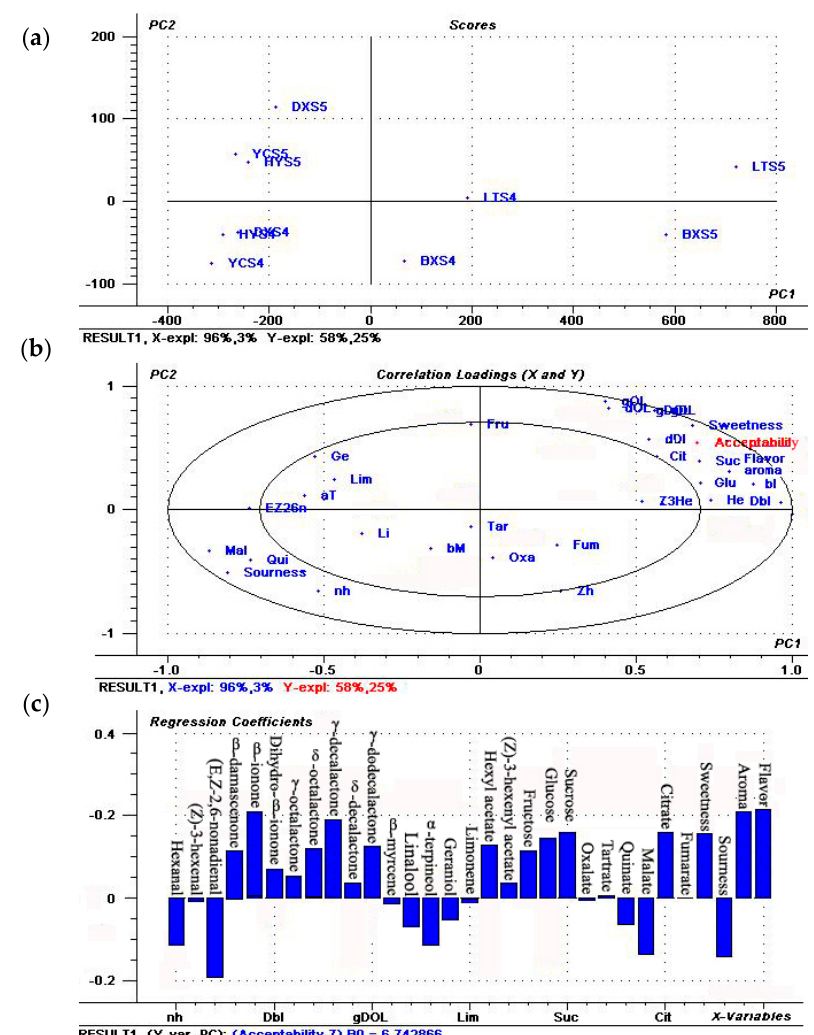
Figure 6. The PLSR model of flavor compounds and sensory attributes of apricot fruit. ( a ) Scores plot, the first two capital letters represent the genotypes described in Table 1 and Tables S4 and S5 represent the last ripening stage of apricot fruit, blue word represents the independent variable, and red word represents the dependent variable; ( b ) Correlation loadings. Flavor compound codes and sensory parameters are indicated in Tables 2 and 3; ( c ) Regression coefficients from the PLSR model of flavor compounds and sensory attributes (X variables) versus consumer acceptances (Y variable) for apricot fruit during ripening.